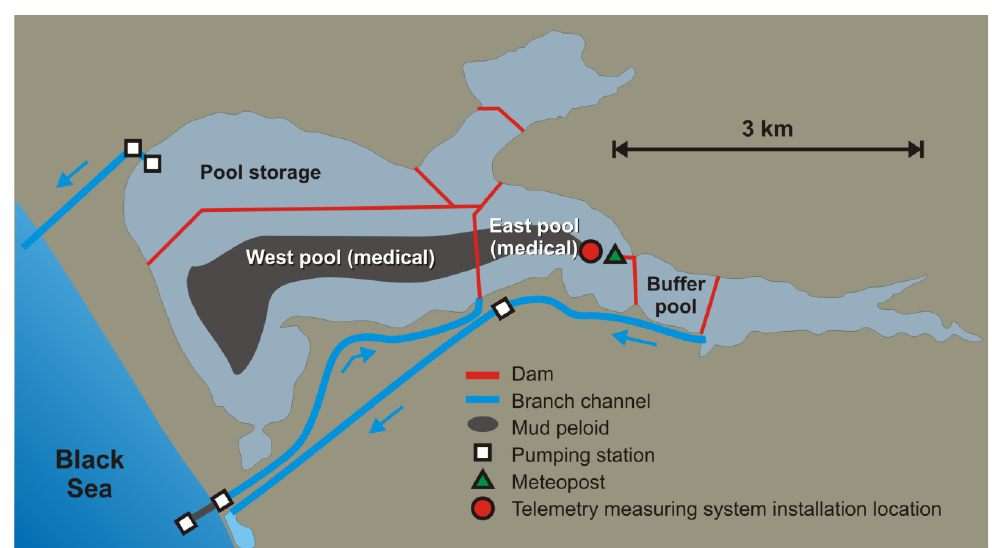
Figure 3. The pools of Saki Lake.